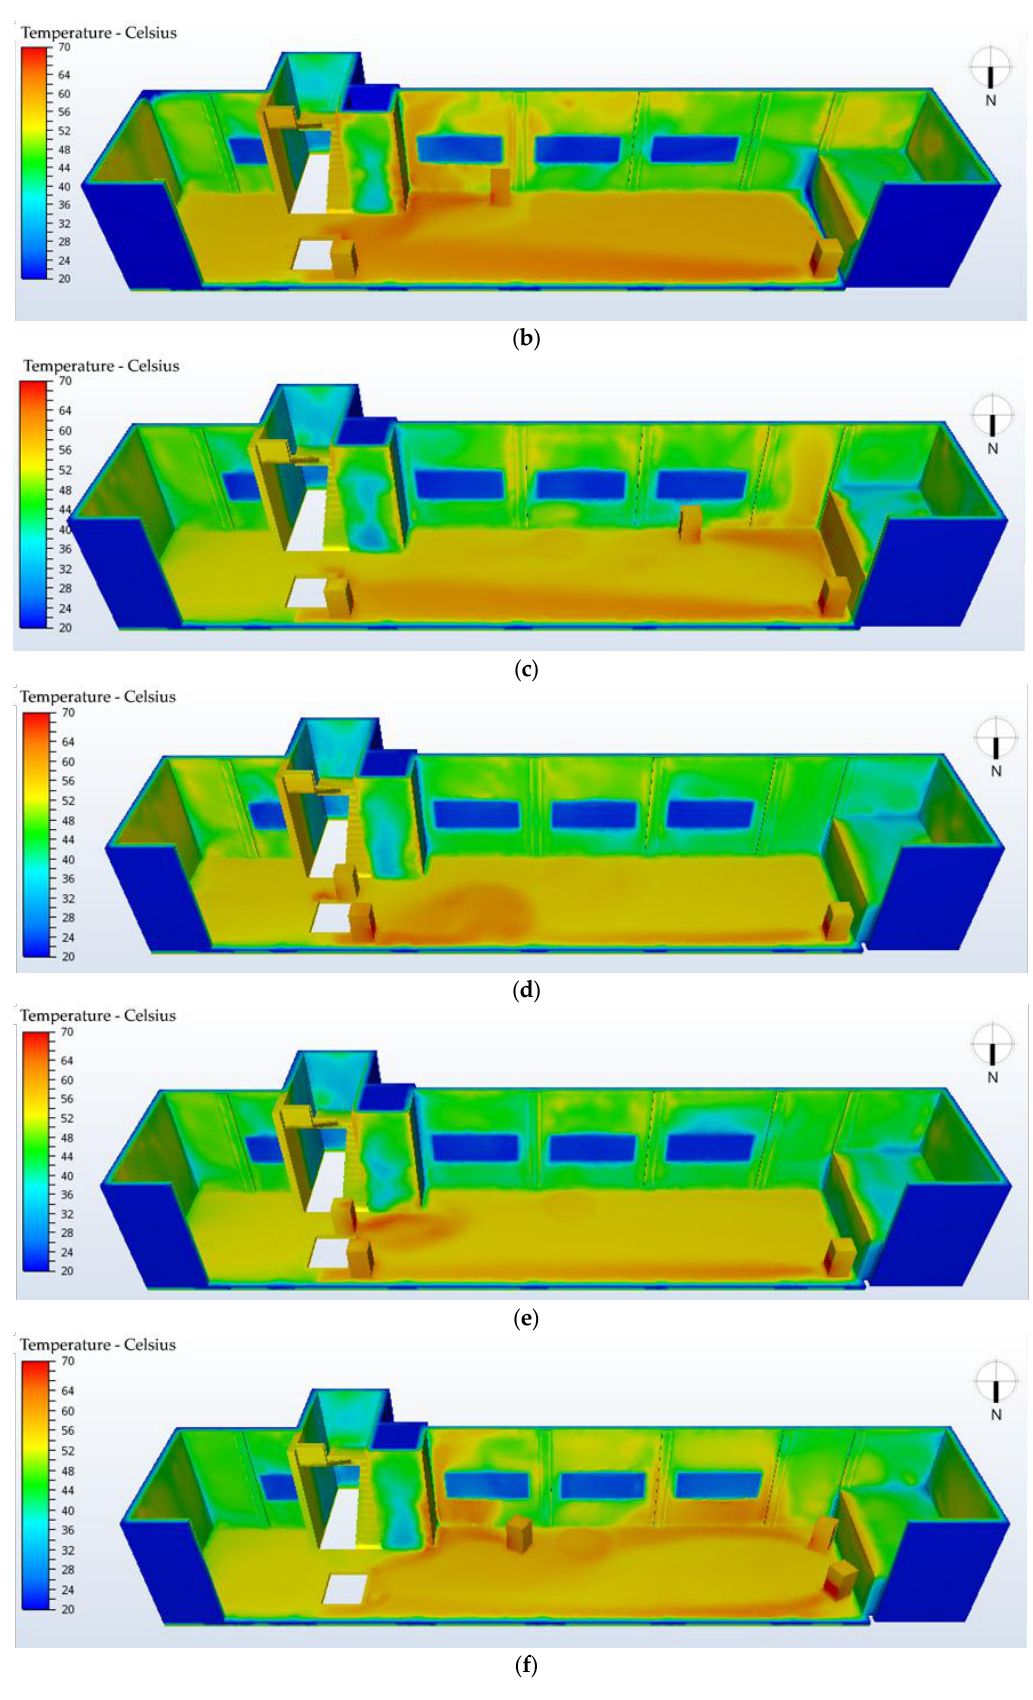
Figure 6. Perspective view (without showing machinery) of the south wall. ( a ) Initial configuration, ( b – f ) changes in the position/orientation of the fan